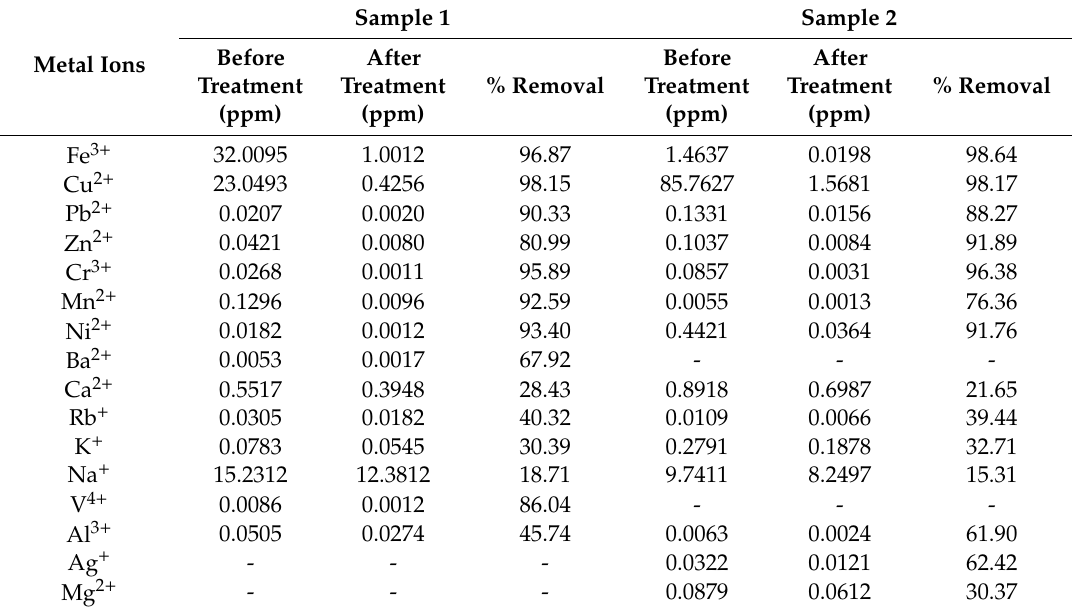
Table 5. Compositions of metal ions into industrial wastewater samples (Sample 1 and Sample 2) before and after treatment by PHA